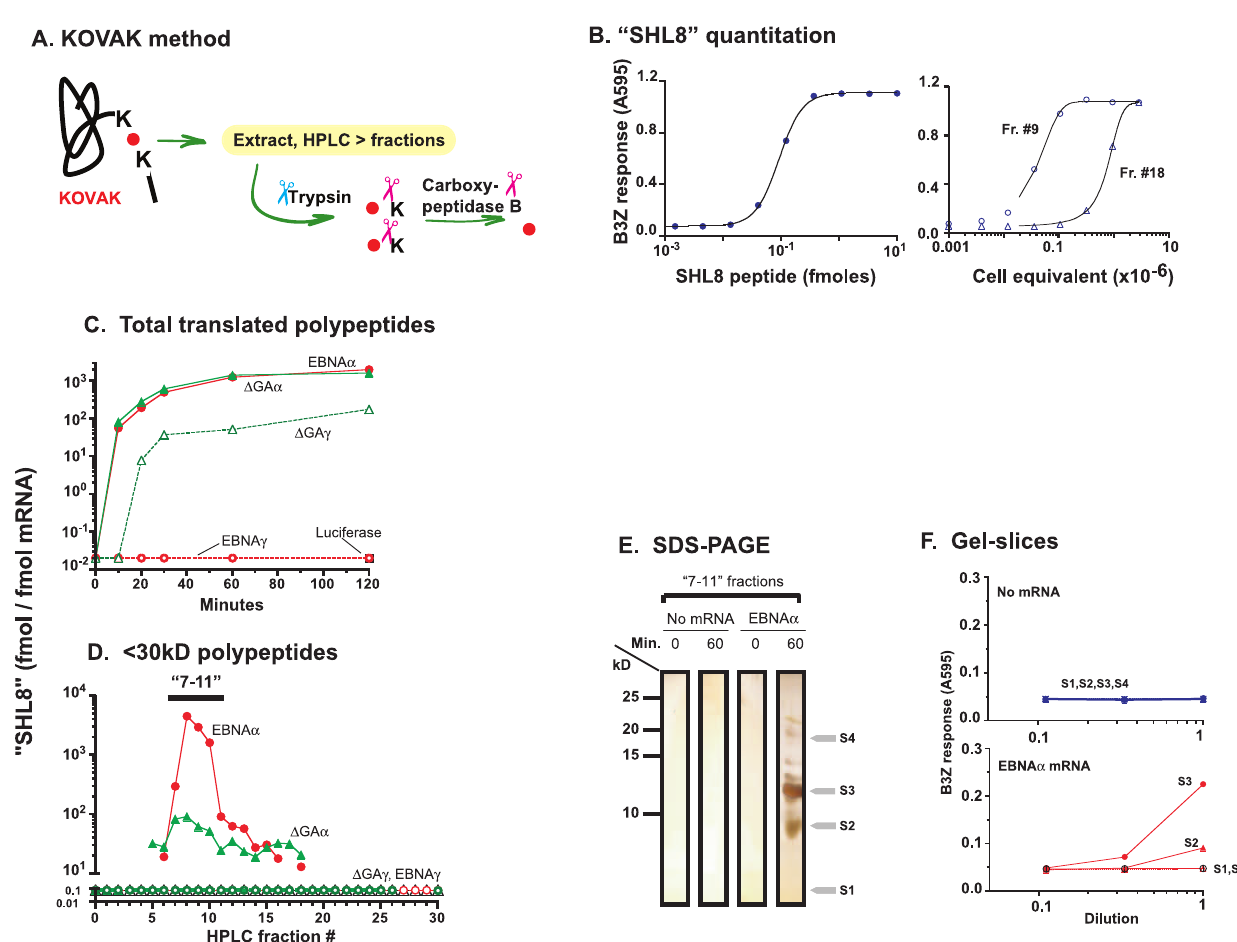
Figure 4. Truncated translation products are antigenic precursors. ( A ) Schematic illustration of the KOVAK method for detection and quantitation of proteolytic intermediates. The SHL8 (SIINFEHL) codons (red circle) are flanked at the N- and C-termini by lysine (K) residues. The putative products of translation are collected in 10% acetic acid before HPLC fractionation. Each fraction is treated with trypsin and carboxypeptidase B (CPB) to release the optimally active SHL8 peptide. ( B ) The amount of embedded SHL8 in the proteolytic intermediates (‘‘SHL8’’ activity) is shown in two representative HPLC fractions ( # 9 and # 18). The B3Z stimulating activity in dilutions of fraction # 9 and # 18 was compared with a standard curve generated with synthetic SHL8 peptide. ( C ) The indicated mRNA coding for EBNA a , EBNA c , D GA a , D GA c and luciferase as a negative control, were translated in vitro for varying time periods. Polypeptides in aliquots of the translation reactions were extracted assayed without HPLC fractionation as in (A). ( D ) Products translated in 60 min. in vitro from the indicated mRNAs were passed through a 30kD molecular weight filter. The filtrate ( , 30kD) was fractionated by HPLC and the amount of ‘‘SHL8’’ activity in each fraction was determined. Data shown represent 3 different experiments. ( E ) Polypeptides translated from EBNA a mRNA and eluting in ‘‘7–11’’ HPLC fractions in (C) were fractionated on high resolution tricine 16.5% SDS-PAGE gels. ‘‘No mRNA’’ samples were analyzed in parallel as negative controls. The silver-stained gel shown is representative of 3 different experiments. ( F ) Indicated slices (S1–S4) were excised from the gel, treated with trypsin and CPB and dilutions were tested for ‘‘SHL8’’ activity with SHL8/K b -specific B3Z lacZ inducible T cell hybridoma and K b -L cells as APC. The conversion of the lacZ substrate chlorophenol b -D-pyrannoside was measured as absorbance at 595 nm with 655 nm as reference wave length. Data are representative of 3 different